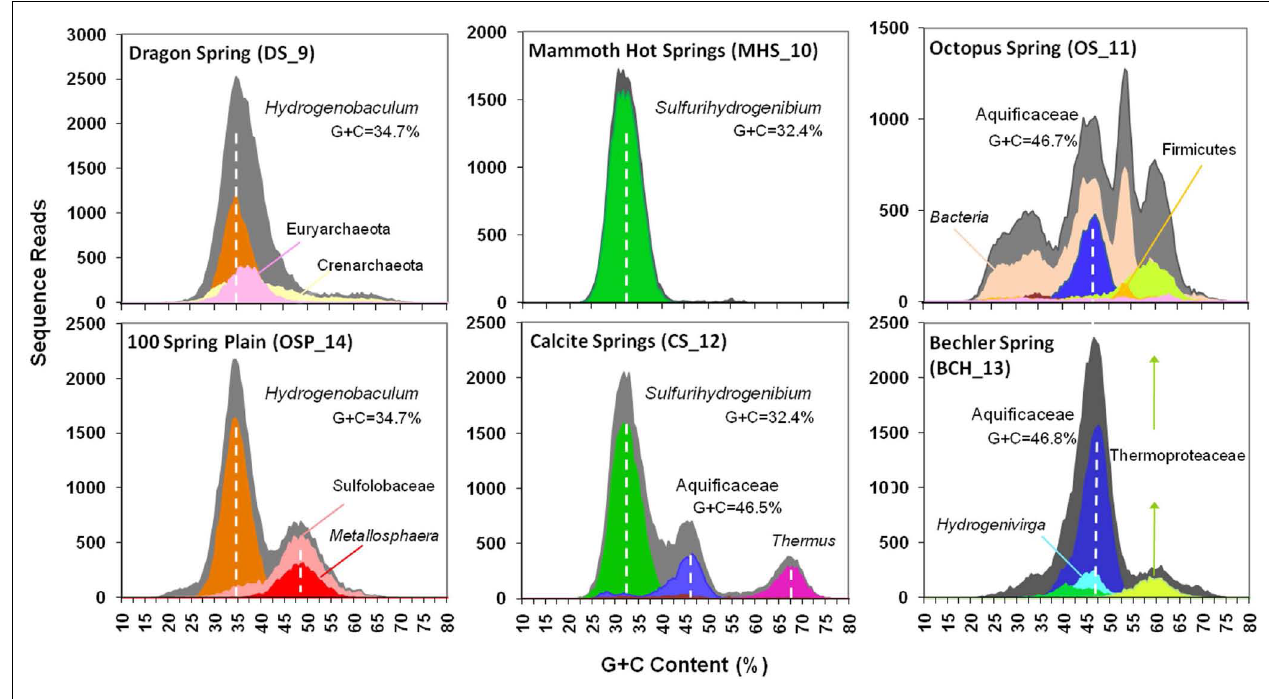
metagenome sequence in these environments (gray = total reads; orange = Hydrogenobaculum; red = Metallosphaera; green = Sulfurihydrogenibium; violet = Thermus; blue = Aquificaceae; light-blue = Hydrogenivirga ; light-orange = Domain Bacteria ; light-green =